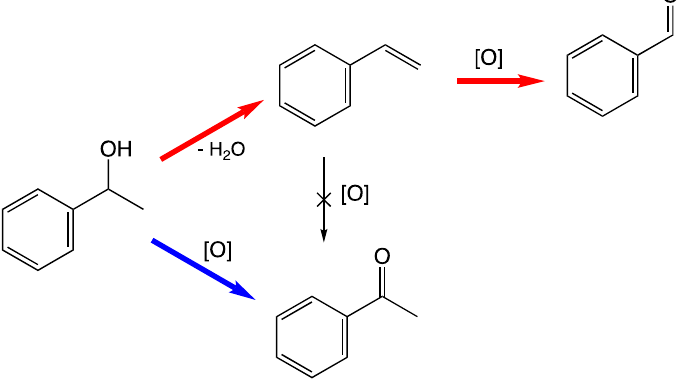
Table 1. Selected catalytic results for the reaction of 1-phenylethanol catalyzed